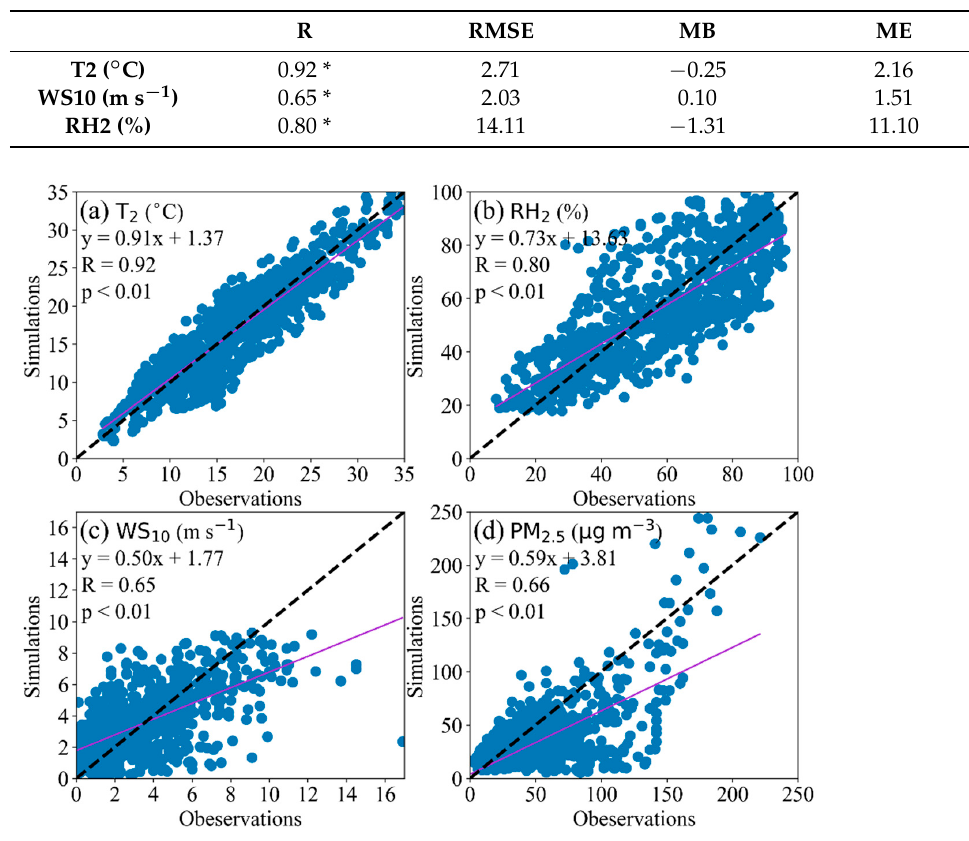
Table 3. Statistical metrics between observed and simulated meteorological parameters averaged over 11 typical sites during 24–26 March 2017. The “*” indicates R passed the 99.9% confidence level.